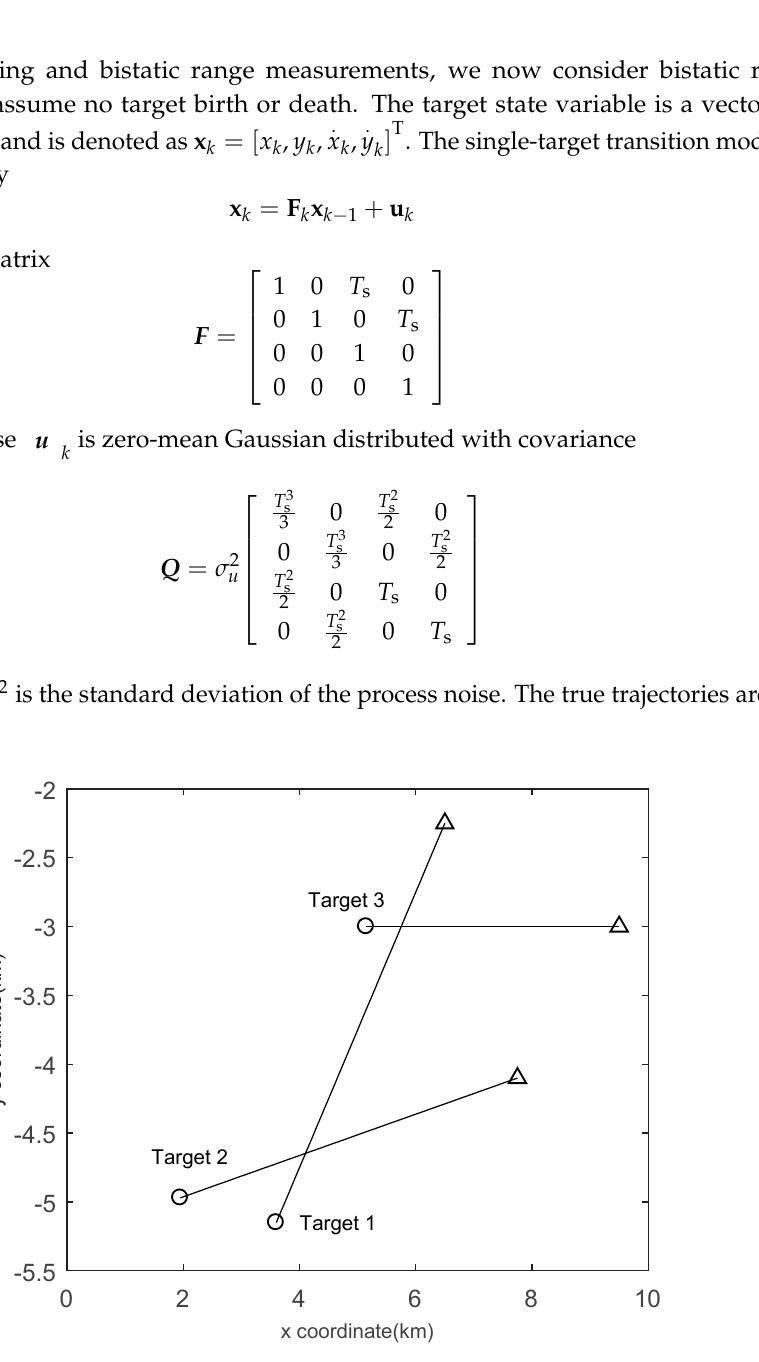
Figure 7. Target trajectories of Scenario 2 in the x / y plane. Start/Stop positions for each track are shown with ○ / △ .